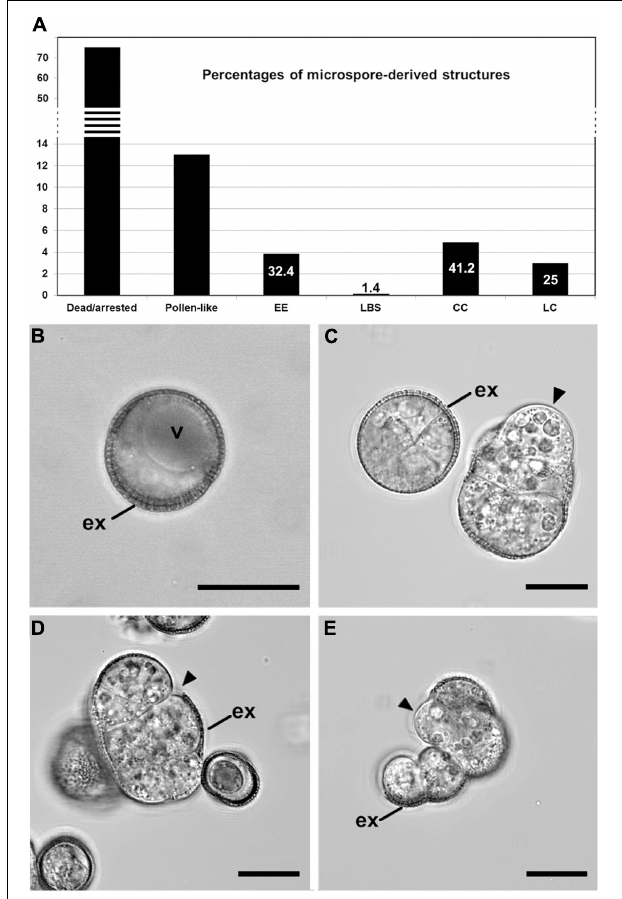
FIGURE 1 | Development of isolated microspore cultures. (A) Percentages of the different structures derived from in vitro cultured microspores, including dead or arrested microspores, pollen-like structures, exine-enclosed (EE) structures, loose bicellular structures (LBS), compact calli (CC), and loose calli (LC). Percentages were calculated from a total of 1245 randomly selected structures. The numbers in EE, LBS, CC, and LC represent the relative percentages of each type of potentially embryogenic structure, excluding non-embryogenic forms (dead/arrested and pollen-like). (B–E) Confocal microscopy images of a vacuolated microspore at the start of culture (day 0; B ), an EE structure ( C left), a LBS ( C right), a CC (D) , and a LC (E) . Arrowheads point to areas devoid of exine (ex). Bars: 20 µ